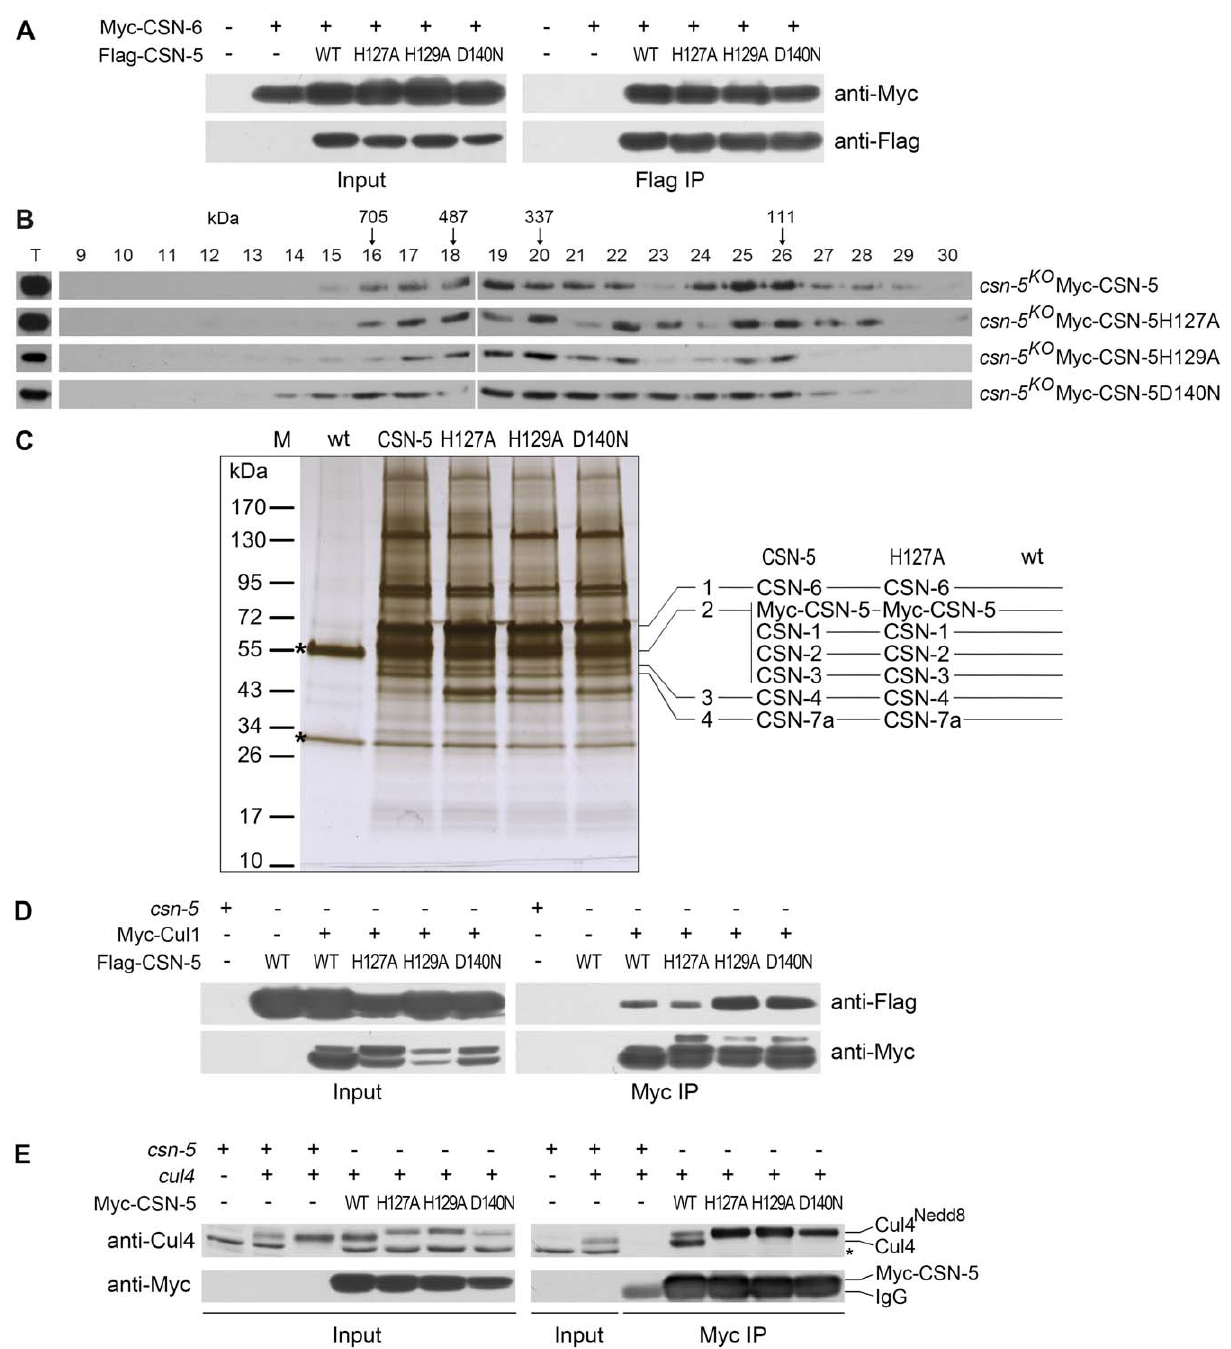
Figure 3. Point mutations do not disrupt integrity of the CSN or interactions of the CSN with Cul1 and Cul4. (A) Immunoprecipitation assays confirming interactions between different versions of Flag-CSN-5 and Myc-CSN-6. Wild-type strain and wild-type strain expressing Myc-CSN-6 were used as negative controls. (B) The Myc-CSN-5, Myc-CSN-5H127A, Myc-CSN-5H129A, or Myc-CSN-5D140N in csn-5 KO properly incorporates into CSN complex. (C) Silver-stained SDS-PAGE showing the two-step purification of Myc-His-CSN-5, Myc-His-CSN-5H127A, Myc-His-CSN-5H129A, or Myc- His-CSN-5D140N in the csn-5 KO strains. A wild-type strain was used as the negative control. CSN subunits identified by mass spectrometry analysis in products of Myc-His-CSN-5 or Myc- His-CSN-5H127A are indicated. Asterisks indicate the two IgG bands. (D) Immunoprecipitation assays confirming the interaction between different versions of Flag-CSN-5 and Myc-Cul1. (E) Immunoprecipitation assays showing the interaction between different versions of Myc-CSN-5 and endogenous Cul4. The asterisk indicates a nonspecific cross-reacted protein band recognized by our Cul4 antiserum. doi:10.1371/journal.pgen.1002712.g003 (NCU04785), another F-box–containing protein in N. crassa , can undetectable after 3 h of CHX treatment (Figure 6A and 6B). In also interact with SKP-1 (data not shown). As shown in Figure 6C the csn-5 H127A strain, the detection of Myc-SCON-2 signal ex- tended to 6 h after CHX treatment (Figure 6A and 6B). FBP94 and 6D, FBP94 was quite stable in the wild-type strain and csn-5 KO